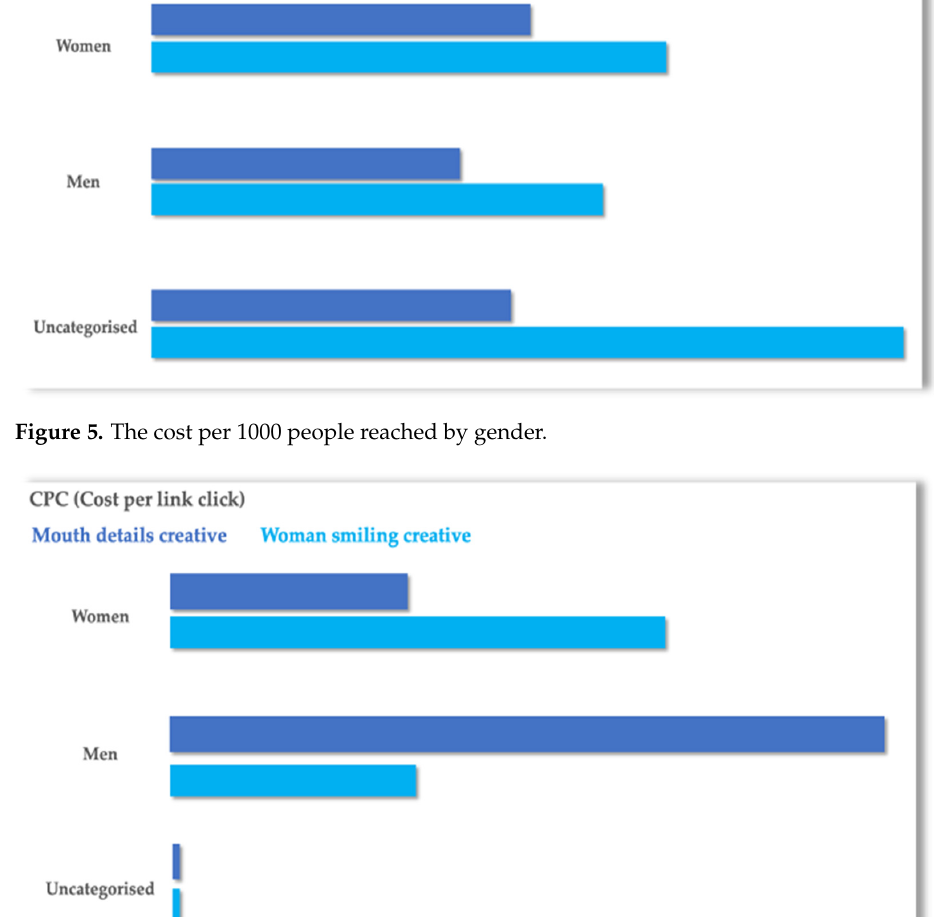
Figure 6. Cost per link click by